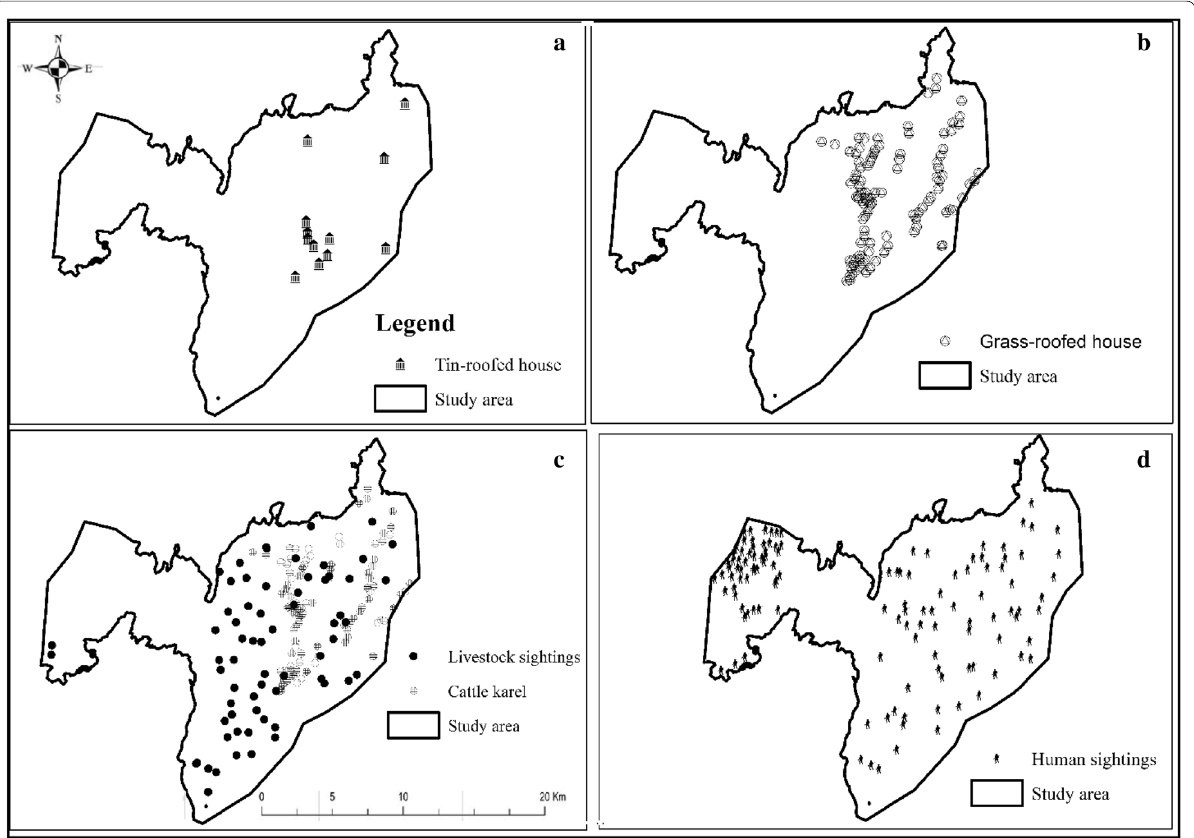
Fig. 4 Human land use in the Nech Sar National